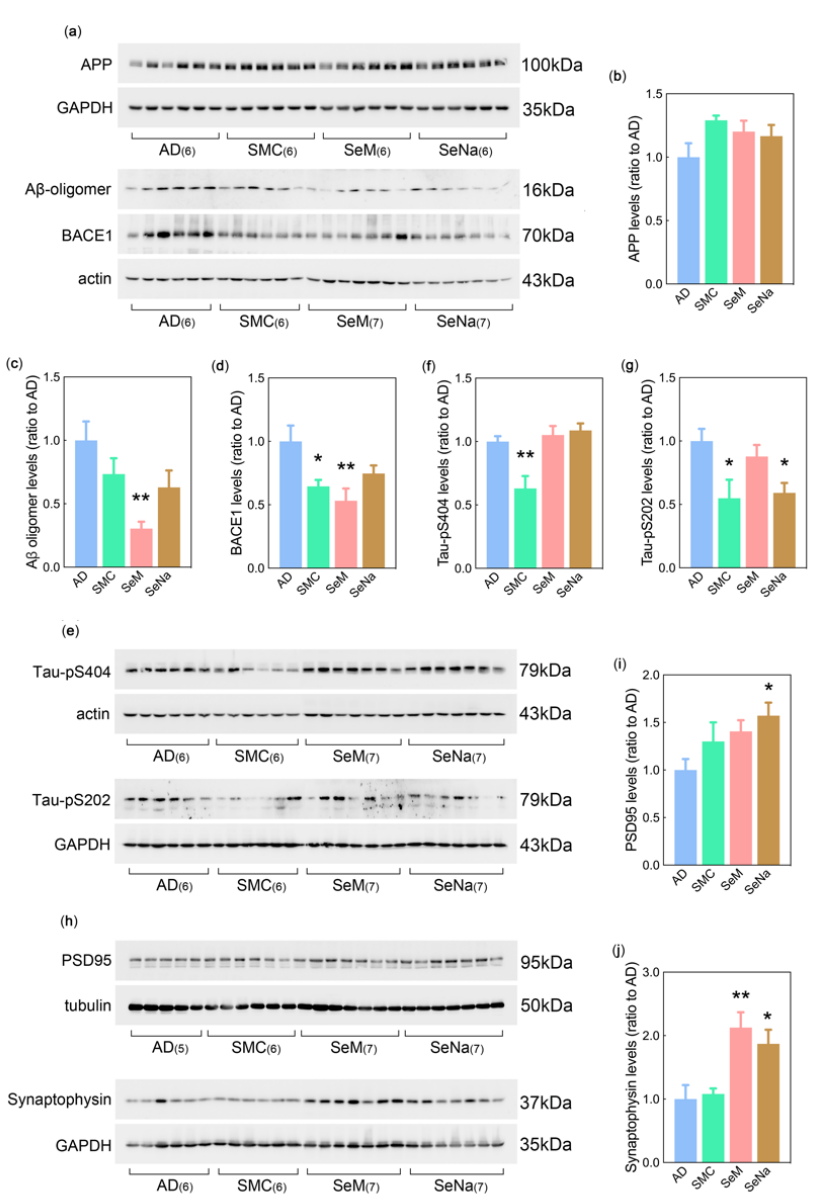
Figure 2. Administration of SMC, SeM, and SeNa improved A β , tau, and synaptic pathology in the cortexes of 3 × Tg-AD mouse brains. ( a ) Levels of APP, A β oligomer (16 kDa), and BACE1 were analyzed by Western blotting. ( b – d ) Quantification of protein levels in ( a ). ( e ) Levels of hyperphosphorylated tau (Ser202 and Ser404) were analyzed by Western blotting. ( f , g ) Quantification of protein levels in ( e ). ( h ) Levels of PSD95 and synaptophysin were analyzed by Western blotting. ( i , j ) Quantification of protein levels in ( h ). α -Tubulin, β -actin, or glyceraldehyde 3-phosphate dehydrogenase (GAPDH) were used as loading controls. All data are presented as the means ± SEMs ( n = 5–7). * p < 0.05, ** p < 0.01 vs. AD mice, as determined by one-way ANOVA followed by Dunnett’s multiple comparison